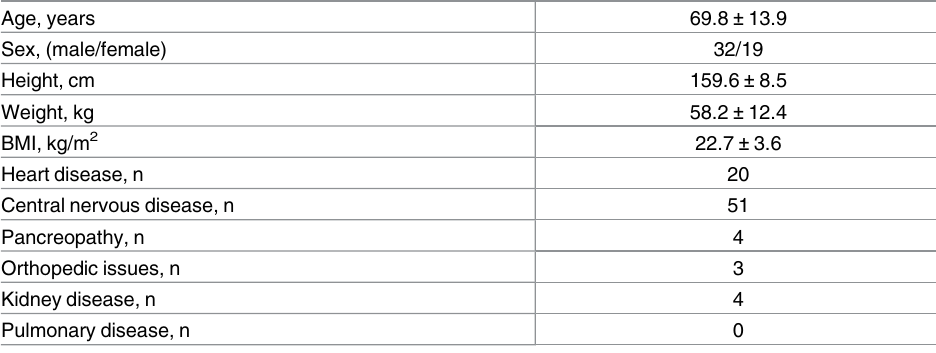
Table 1. Subjects’ characteristics (n = 51).